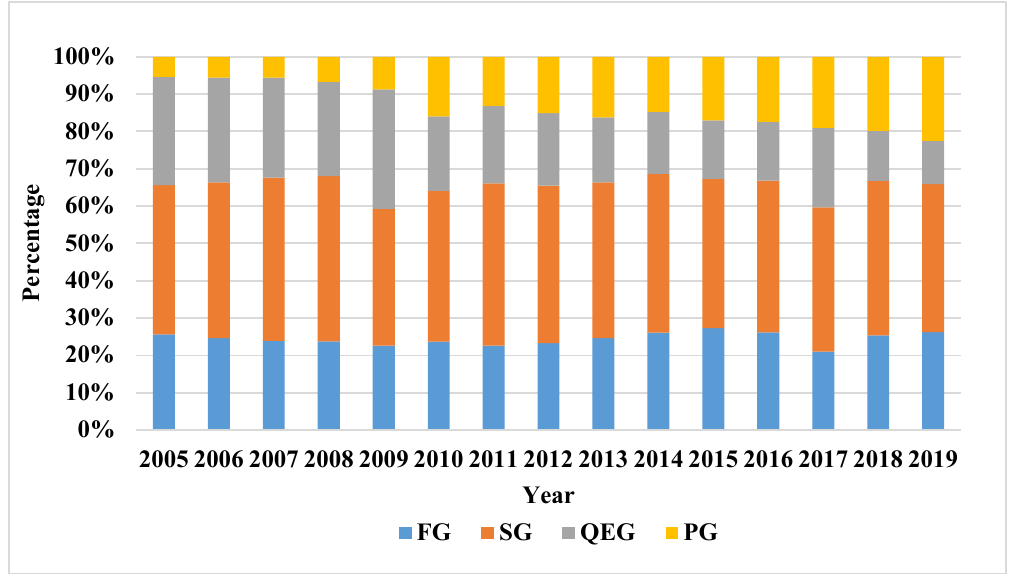
Figure 4. Gini coefficient of development of open economy in YRDA from 2005 to 2019.